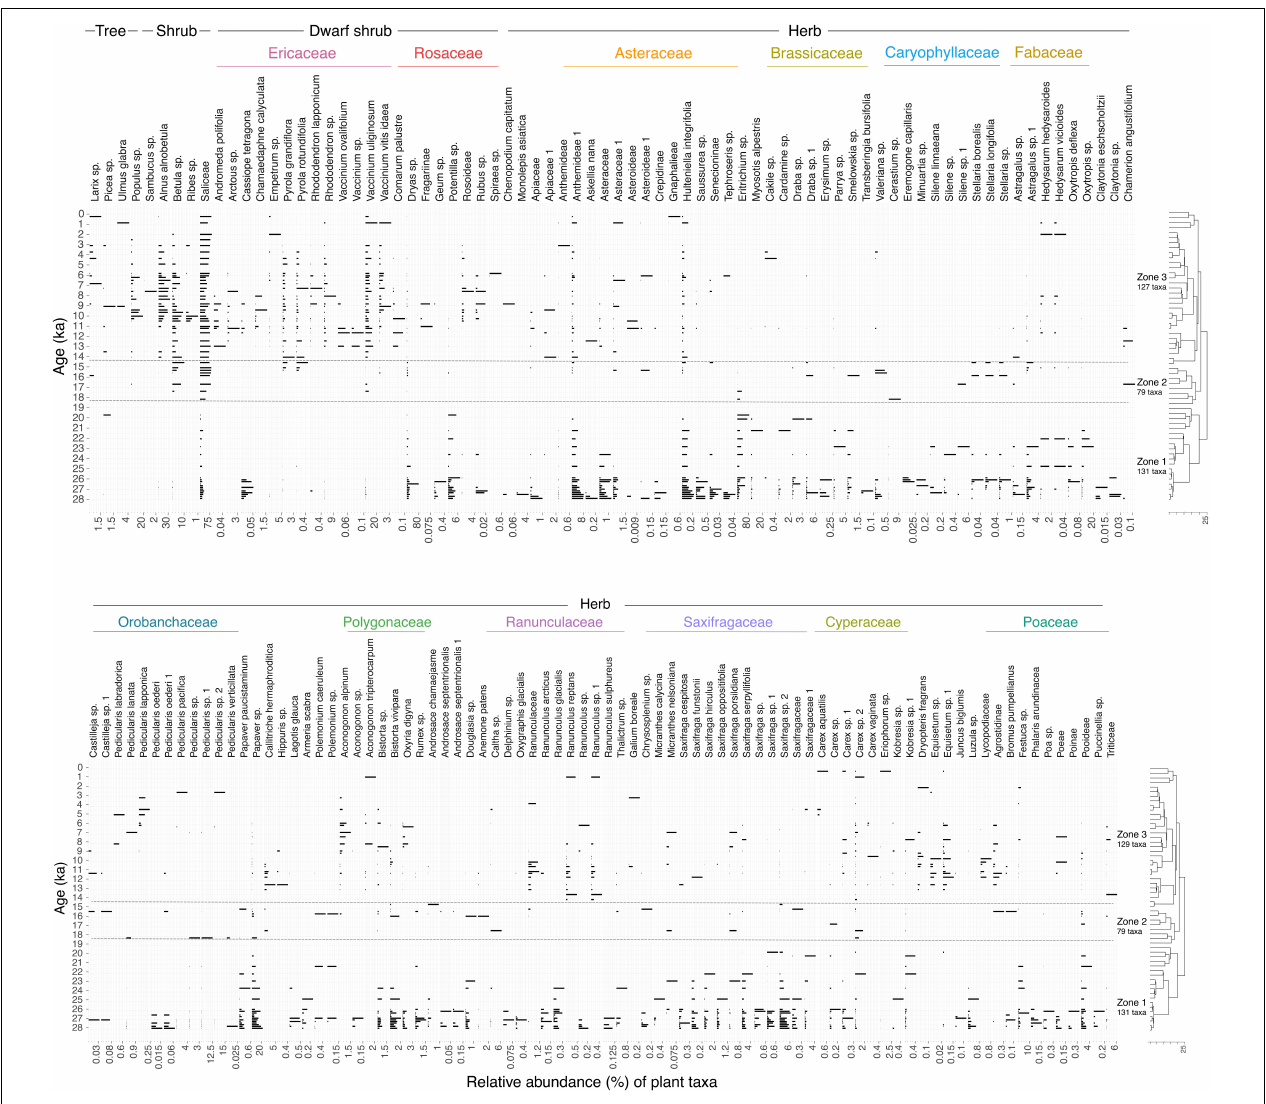
FIGURE 2 | Stratigram of taxa recovered from sedimentary ancient DNA samples showing the relative proportions as a percentage of the plant taxa in each sample (horizontal bars). The plot is split into the upper and lower parts. Zones are derived based on a depth-constrained CONISS cluster analysis. Numbers of plant taxa occurring in each zone are